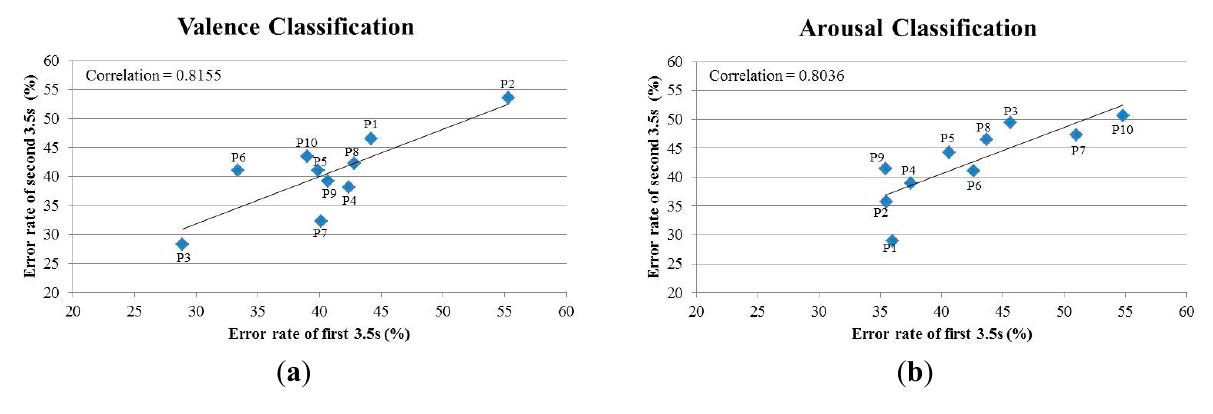
( b ) arousal classifications using SP feature and k -NN classifier.